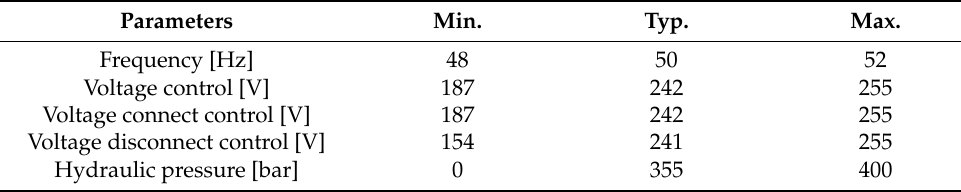
Table 1. Usual parameter values of the studied circuit-breakers. Parameters Min.